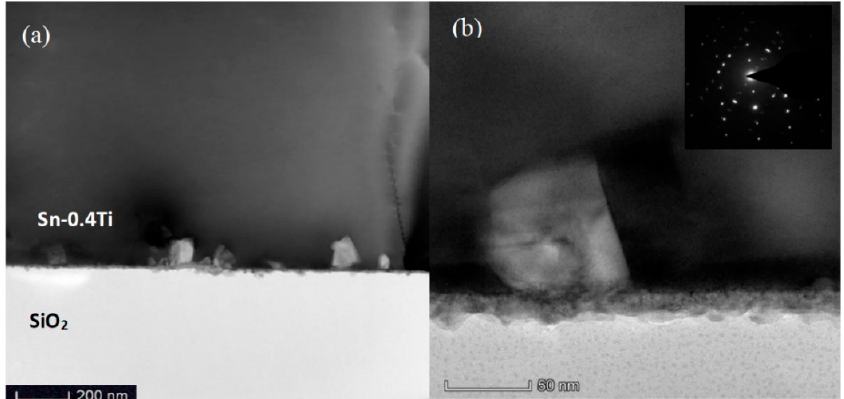
Figure 2. ( a , b ) TEM images of the interfacial area between Sn-0.4Ti alloy and quartz glass (the insert shows selected area diffraction (SAED) pattern of the TiO 2 nanocrystal).